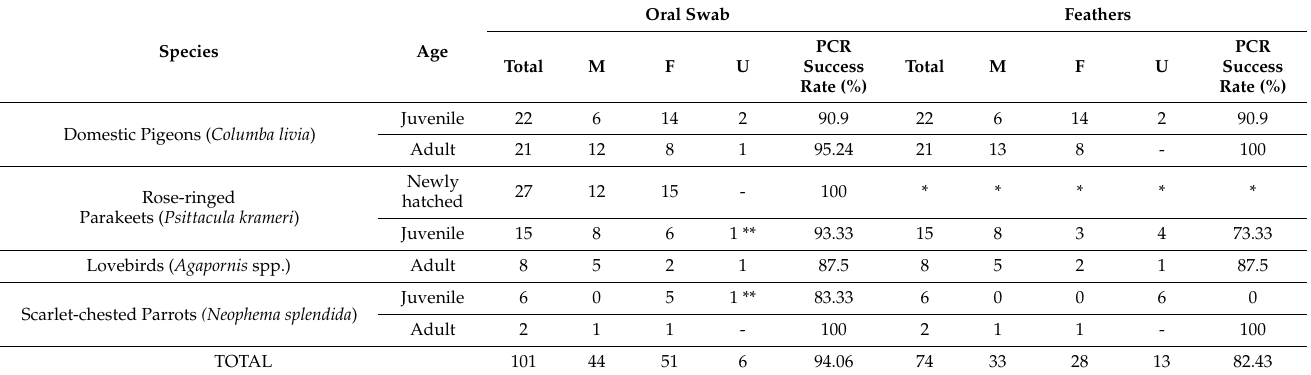
Table 3. Results of molecular sexing juvenile and adult pet birds included in this